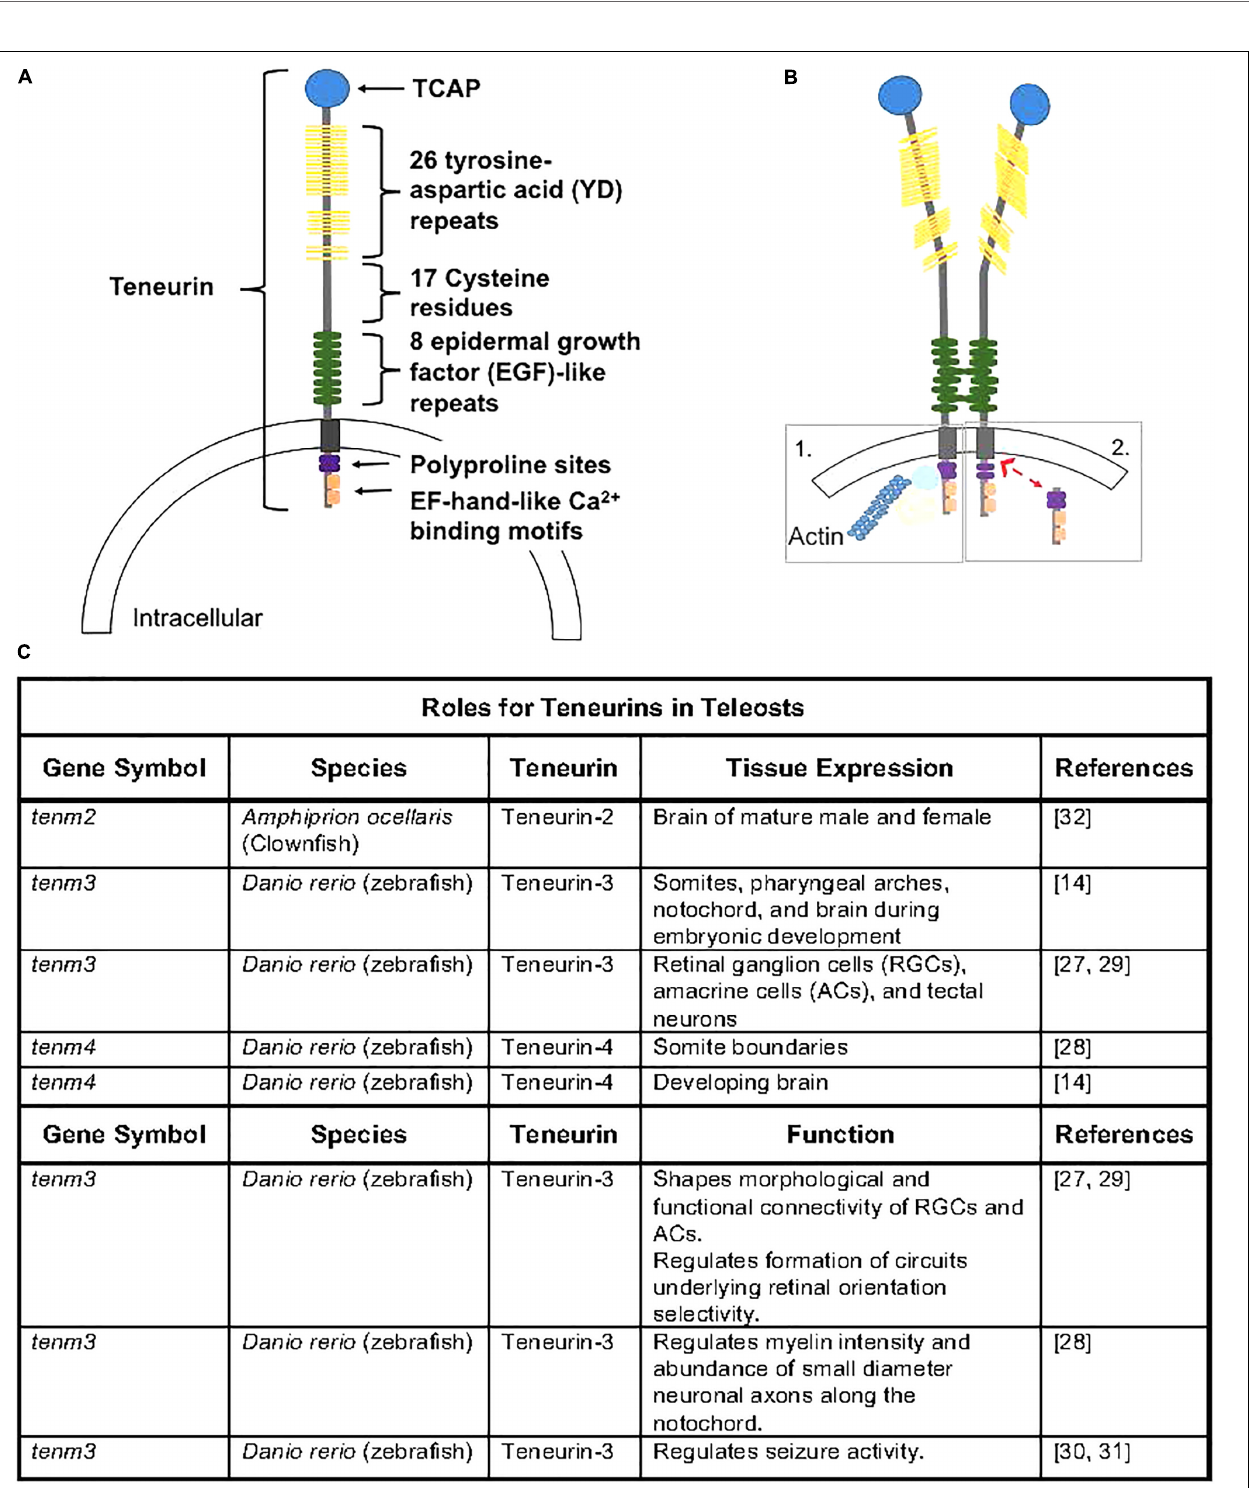
Frontiers in Neuroscience |